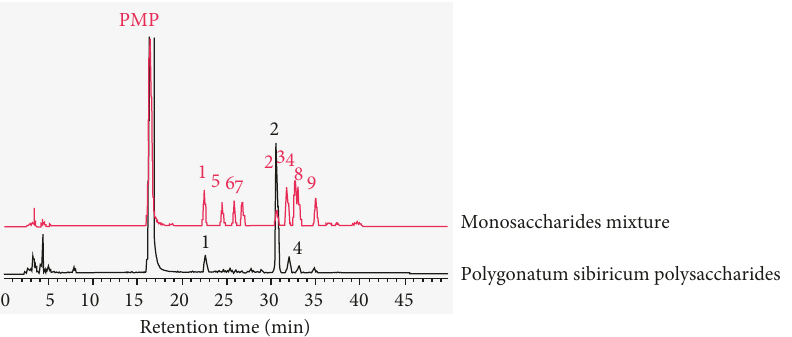
Figure 1: Chromatography of Polygonatum sibiricum polysaccharide (PSP) derivatization. 1: mannose; 2: glucose; 3: galactose; 4: xylose; 5: glucuronic acid; 6: rhamnose; 7: galacturonic acid; 8: arabinose; 9: